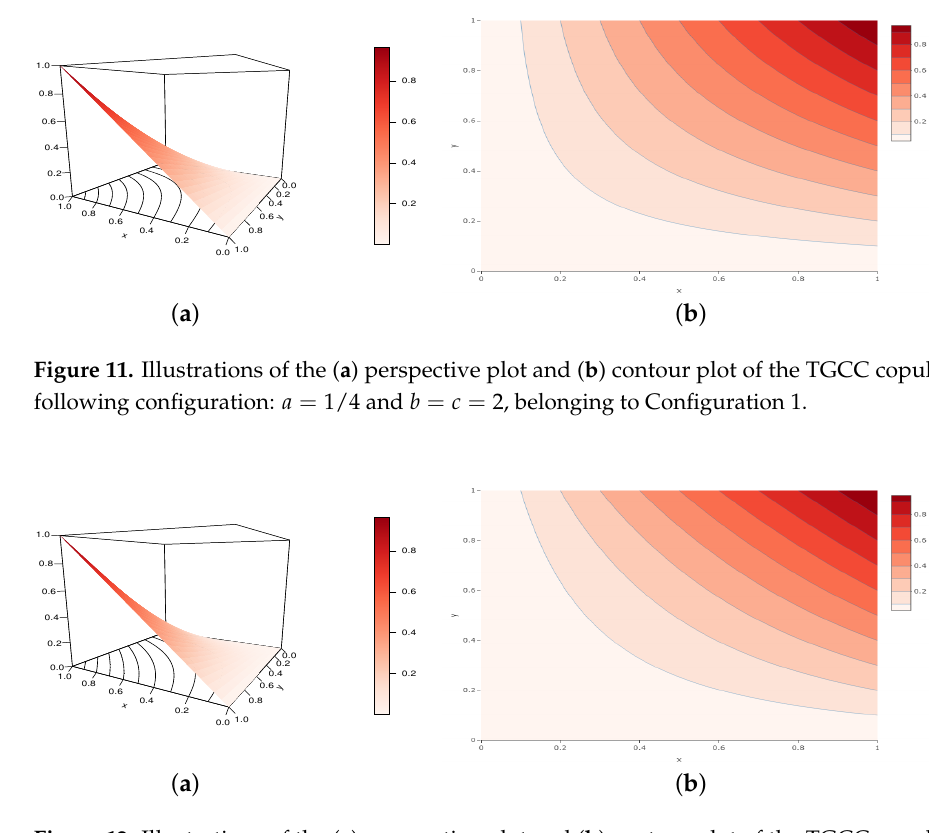
Figure 12. Illustrations of the ( a ) perspective plot and ( b ) contour plot of the TGCC copula for the following configuration: a = − 1/2, b = 2, and c = 1, belonging to Configuration